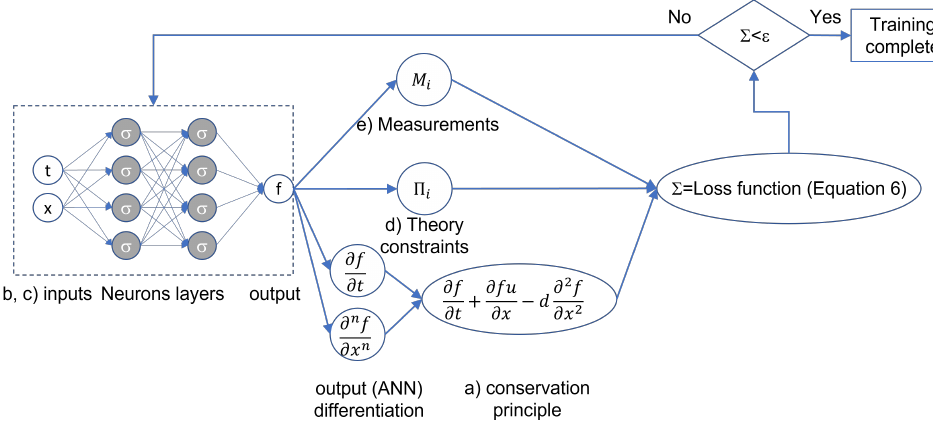
Figure 10. A generalized schematic of the Physics Informed Neural Network (PINN)